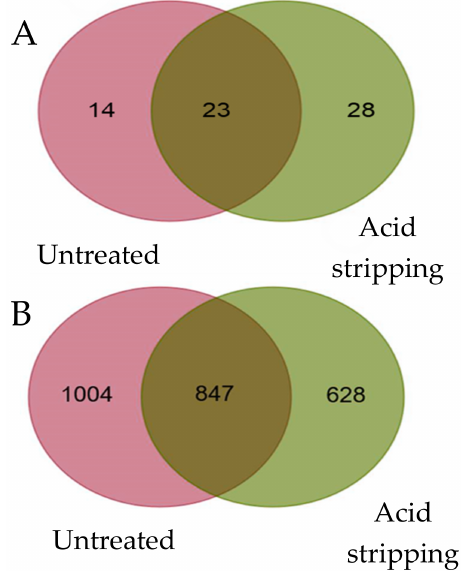
Figure 1. Overlap of HLA-B*27:05 viral and cell ligands from untreated and acid stripping condition VACV-infected cells. Venn diagram showing number de viral ( A ) or cell ( B ) ligands identified exclusively in untreated virus-infected cells (pink), acid stripping condition (green) VACV-infected cells and overlapping peptides between both